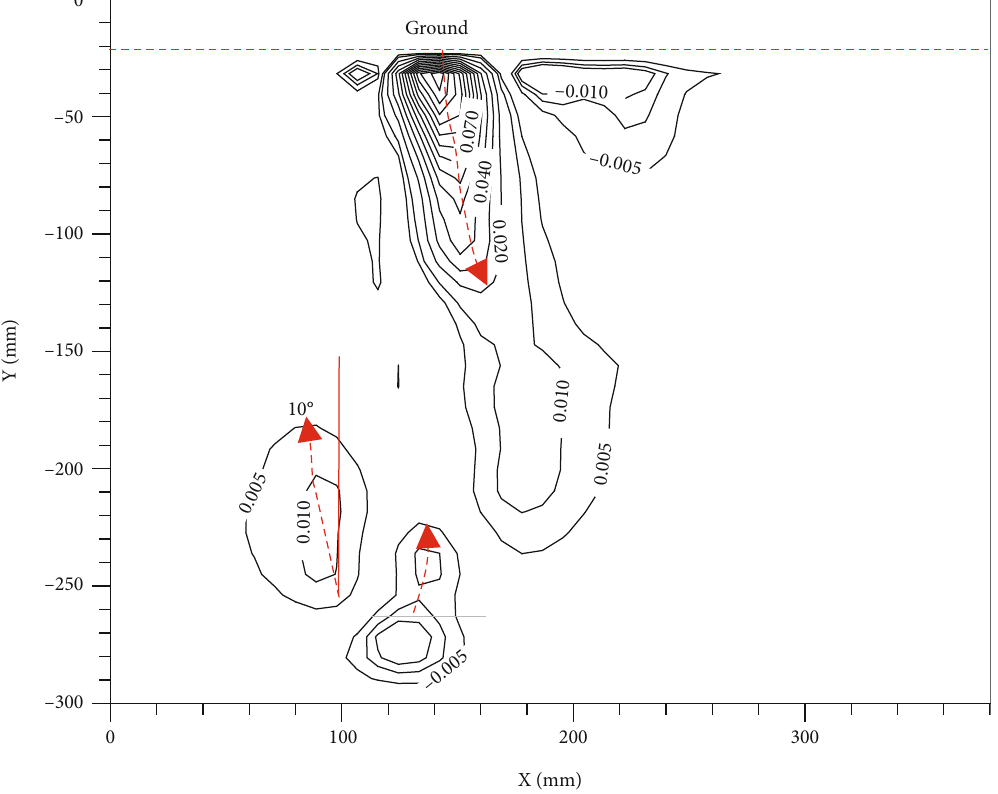
Figure 17: Shear strain fi eld at the ultimate load for D